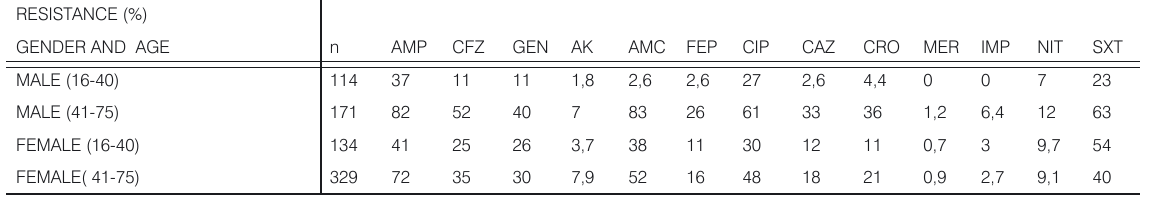
Table 2. The distribution of antimicrobial resistance in nosocomial E.coli isolates according to age and gender.